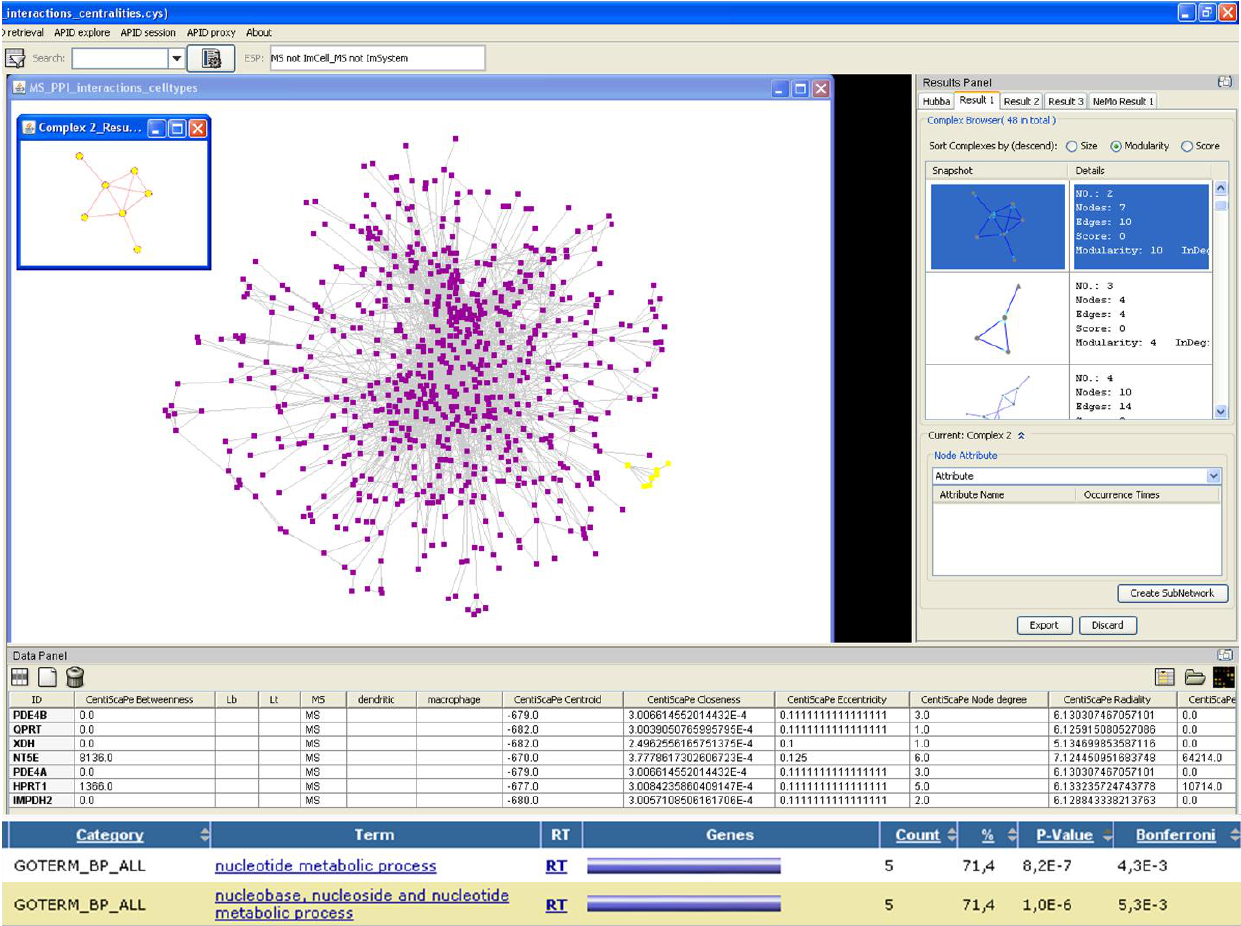
Figure 4. Search for modules in multiple sclerosis PPI network using Cytoscape [8]. At the bottom of the figure, we can see the result of the functional analysis of the module highlighted in yellow, conducted with DAVID